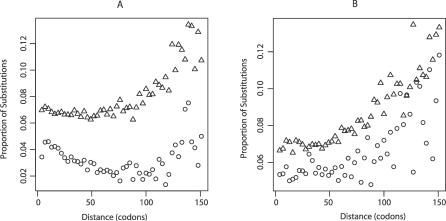
Rate of Nonsynonymous Evolution as a Function of the Distance from an Intron–Exon Boundary for ESS and Non-ESS SequenceThe rate of evolution of sequences defined as part of ESSs (circles) and those not in enhancers (triangles) is shown as a function of the distance from exon boundaries in the mouse–human analysis at (A) the 5′ end of exons and (B) the 3′ end of exons. To define putative enhancer sequence the mouse and human sequence was matched to the set of species-specific, exon-end-specific set of hexamers. Any part of the alignment not found to be enhancer in either species was considered nonenhancer. Any part of the alignment found to be enhancer in both was considered to be enhancer sequence. As can be seen, exonic enhancer sequence evolves more slowly than nonenhancer. Given that functional splice enhancers are rare more than 100 bp from a boundary, it is expected that the further into the exon, the less the difference between enhancer and nonenhancer.